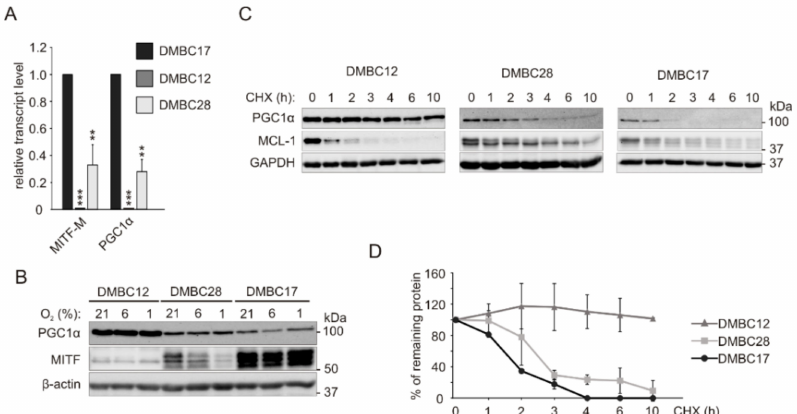
Figure 4. PGC1 α (peroxisome proliferator-activated receptor γ coactivator 1 alpha) protein